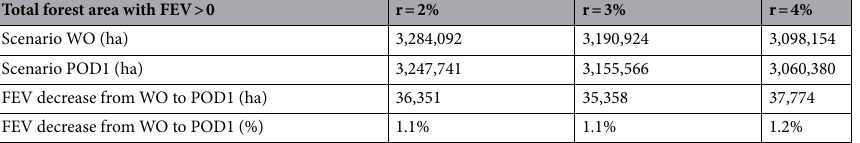
Total forest area with FEV > 0